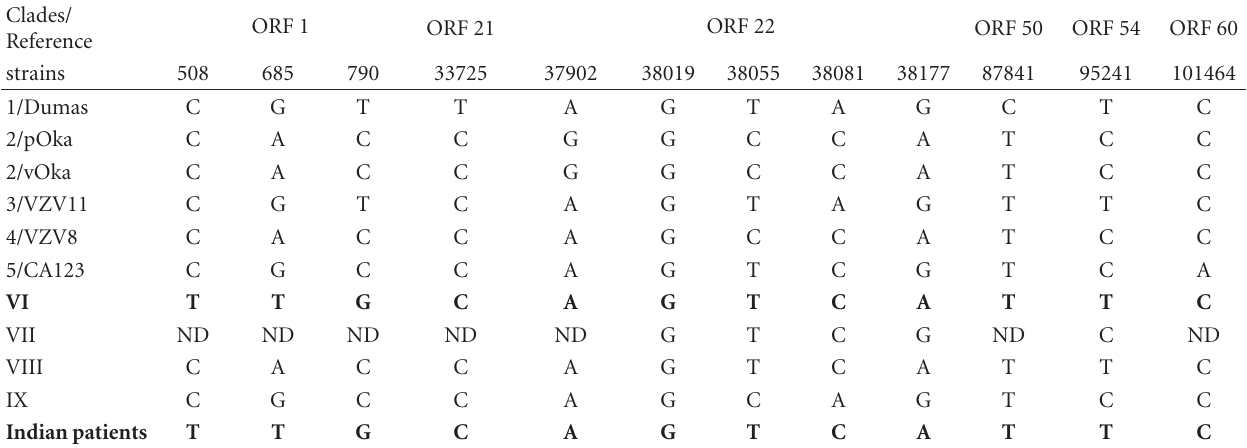
Table 1: Single-nucleotide polymorphisms in VZV strains of the novel provisional clade VI detected in two Indian patients with varicella in comparison to other VZV clades. ORF: open reading frame, ND: not done.